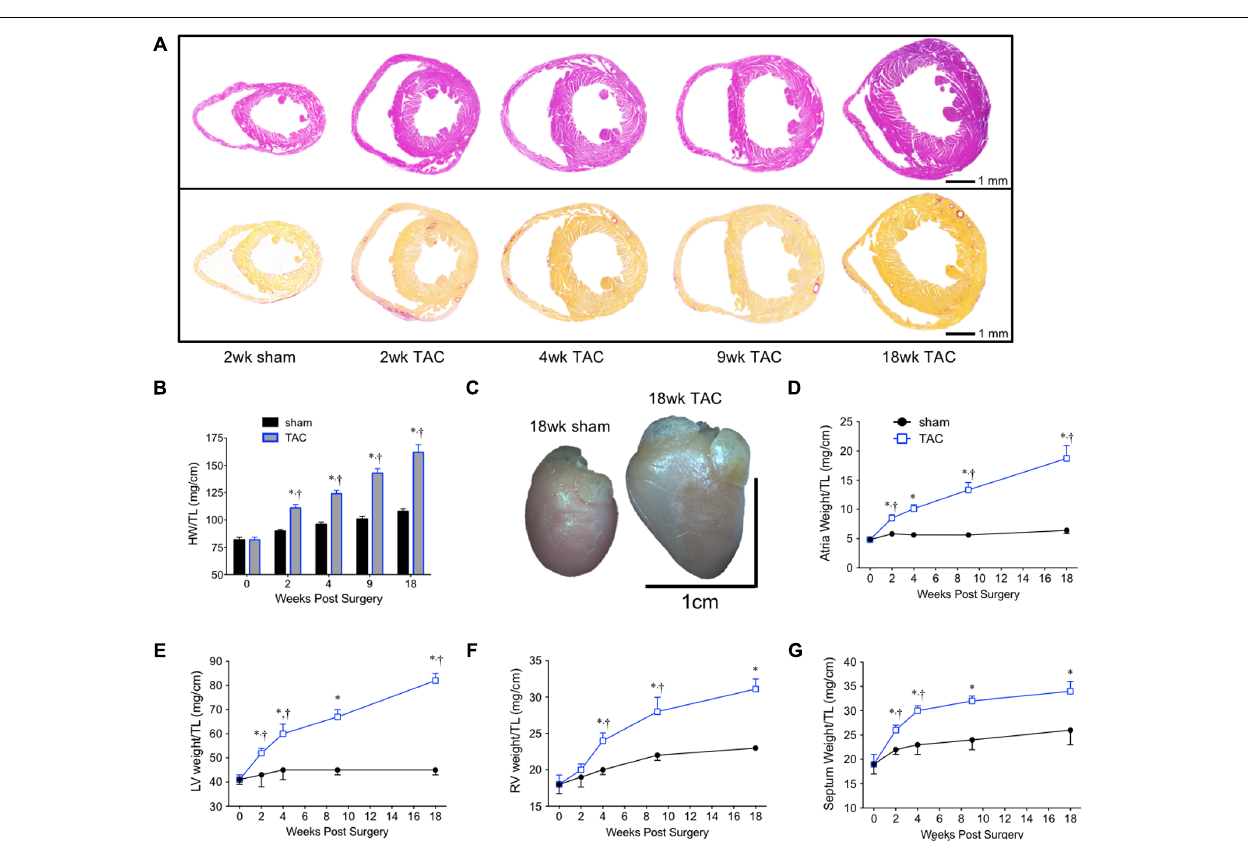
FIGURE 4 | Summary of cardiac morphometrics following 18 weeks of TAC. (A) Representative cross-sectional images of the heart stained with H&E (top row) and PSR (bottom row). (B) Whole heart weight normalized to tibial length (HW/TL). (C) An 18 week sham (left) and TAC (right) heart. Normalized chamber-specific growth curves from the (D) atria, (E) left ventricle (LV), (F) right ventricle (RV), and (G) septum are presented. ∗ p < 0.05 vs. age-matched sham. † p < 0.05 vs. previous time